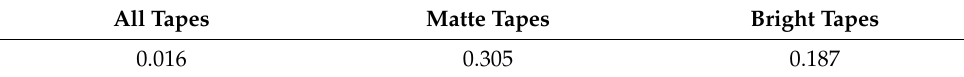
Table 5. p -Values of Kruskal–Wallis test to compare the independent samples.